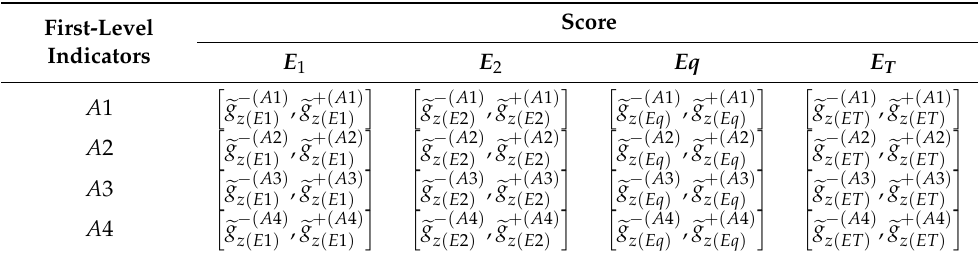
Table 2. Interval Hesitation Fuzzy Element of the First-Level Indicators.